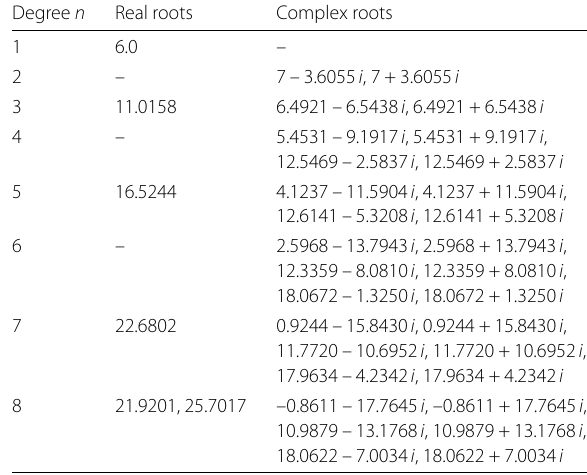
Table 10 Approximate solutions of L e n ( x , y ) Degree n Real